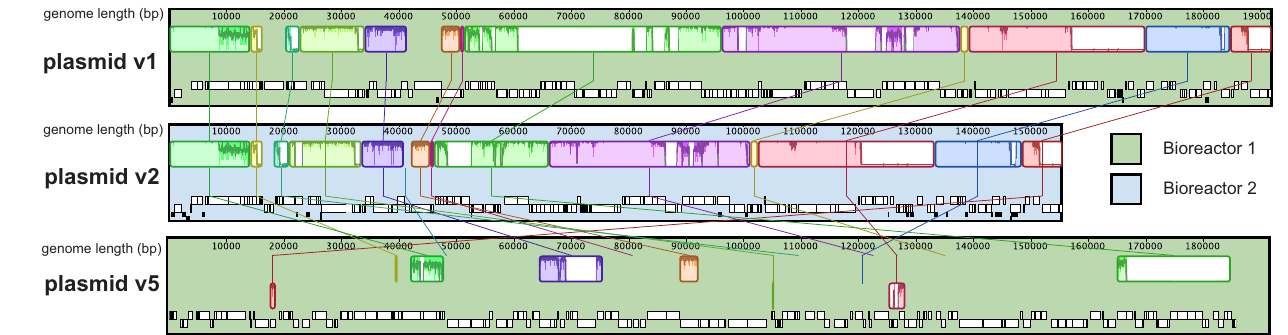
Fig. 3 | Genome alignment of curated plasmid versions v1, v2, and contig of v5. Genomes were aligned with the progressiveMauve algorithm in Geneious.